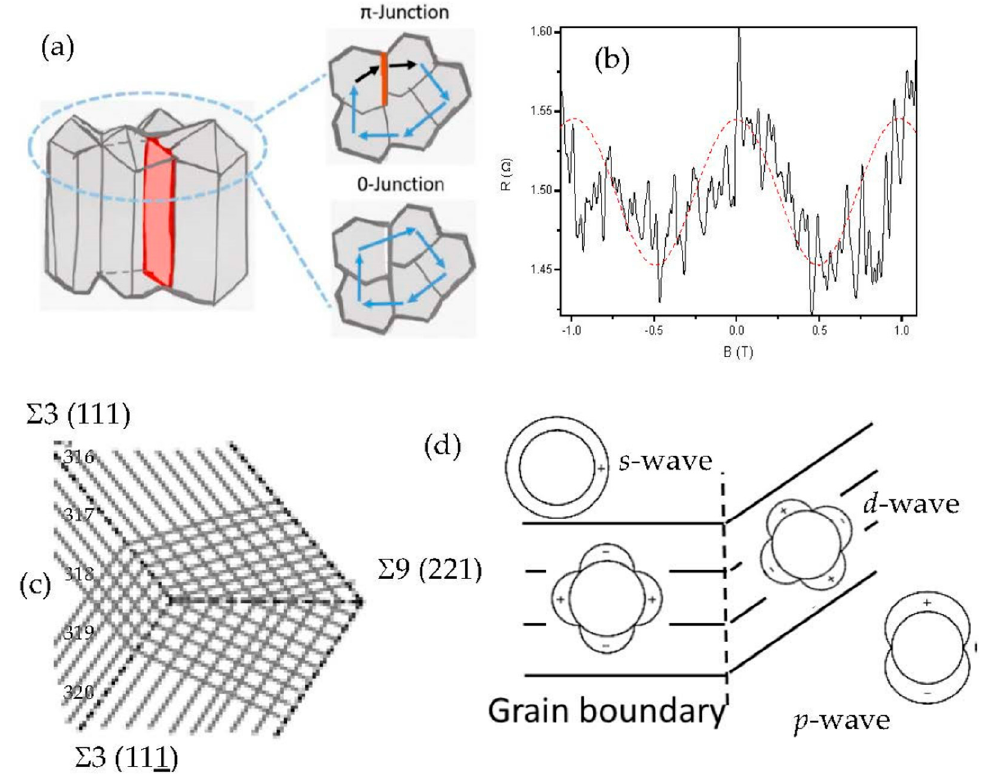
Figure 5. Magnetoresistance ( a ) A schematic indicating the geometry of conduction loops consid- ered using the fitting model, which takes into account interference between 0 − junction (of high transmission) and π− junctions (where phase scattering/spin flipping occurs). ( b ) An oscillatory magnetoresistance (recorded at 2.2 K) shows a more pronounced π− junction character. ( c ) Transport features are explained through the anisotropy of the crystal structures. The high proportion of ∑ 3 boundaries allows for higher-order twinning such as the ∑ 9 and this is schematically shown in [21]. ( d ) The pairing symmetry s , d , and p − wave are shown as a shift of the charge distribution. ( d − wave) Cooper pairs transmit through the grain boundaries.